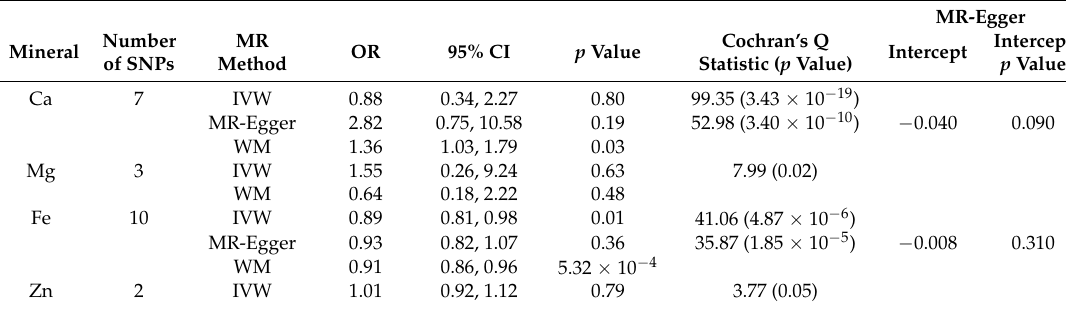
Table 6. MR estimates of the causality between five minerals and T2D.